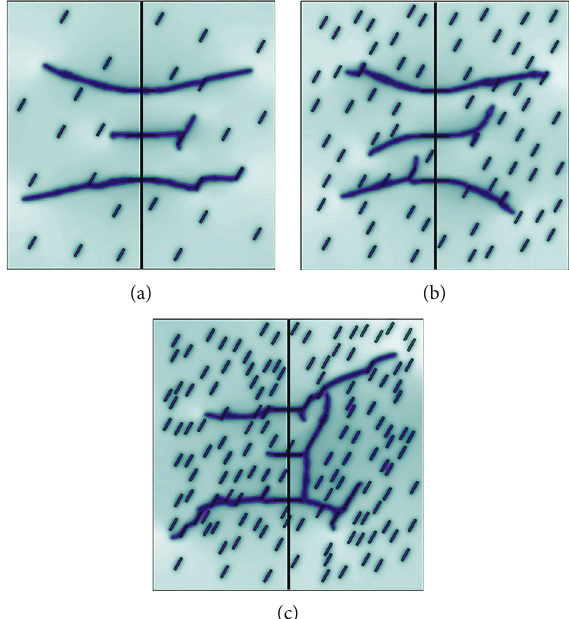
= 7 : 2 × 10 − 3 number/m 2 , (b) ρ n